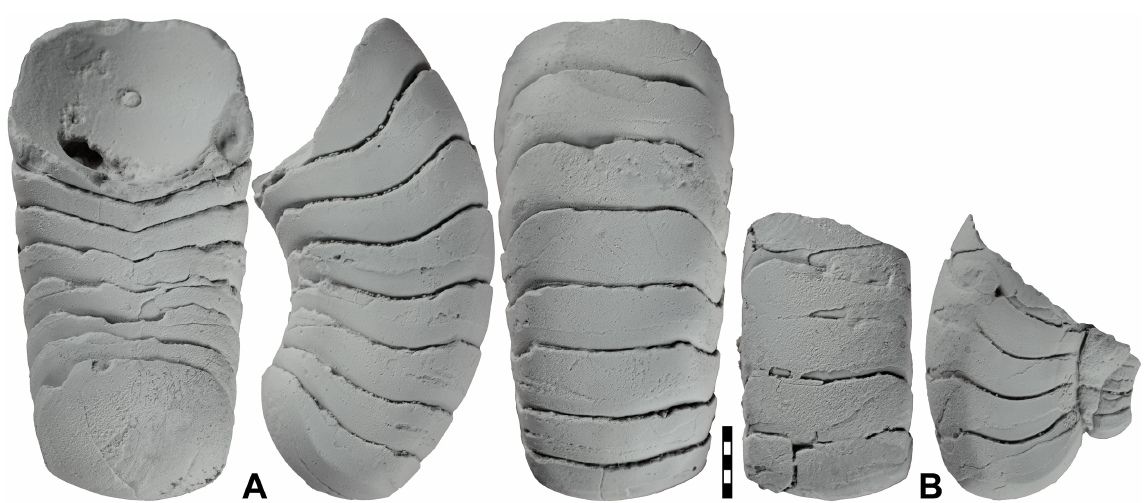
Fig. 26. Maccoyoceras saharensis sp. nov. from Oued Temertasset (all Korn et al . 2002 Coll.). A . Holotype MB.C.30480.1. B . Paratype MB.C.30481. Scale bar units = 1 mm.